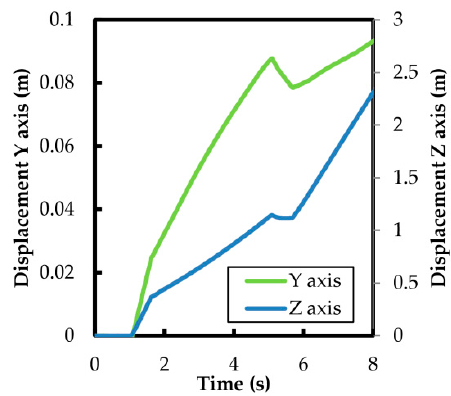
Figure 20. Calculated results of displacement in Y and Z axes; Cross-axis sensitivity affectation observed.